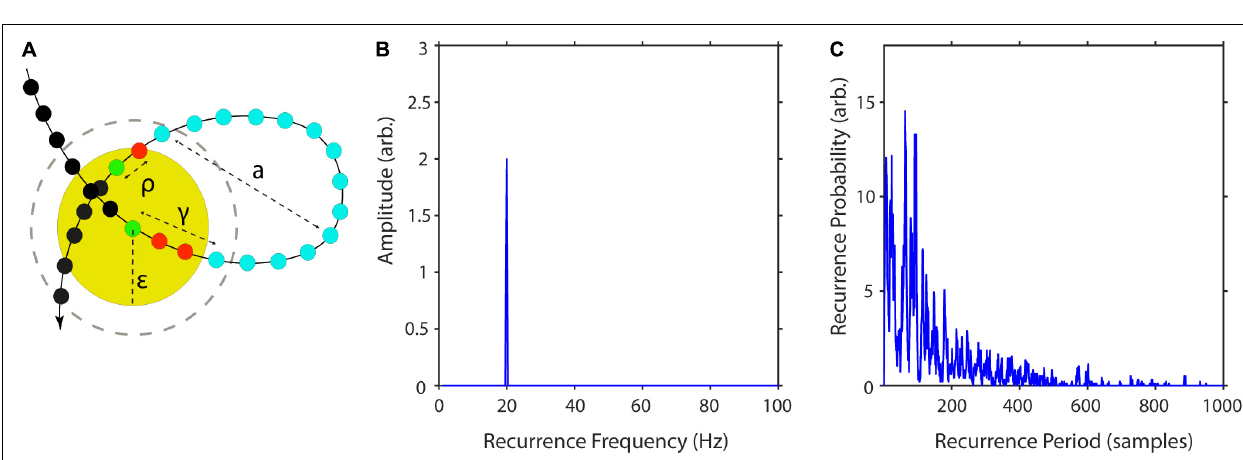
FIGURE 2 | Estimation of recurrence periods. (A) A closed local trajectory in phase-space. A reference point (green) is tracked in time until it reenters its spatial neighborhood (yellow circle) with radius ε . In this example, the recurrence period is equal to 14, as it takes 14 samples (blue) until the trajectory reenters the neighborhood. The recurrence amplitude a is estimated as the maximum distance of the recurrence trajectory. Increasing the neighborhood by a multiple of the state-to-state distance (gray dashed circle) reduces the recurrence period by a multiple of two samples. (B) Example estimation of recurrence amplitudes using the maximum norm. Recurrence amplitude of 5 s of a 20-Hz periodic signal with an amplitude of two. (C) Example estimation of recurrence probabilities for a non-periodic but highly recurrent deterministic system, i.e., the classic Lorenz system (Lorenz, 1963). The plot shows the recurrence probabilities of each period